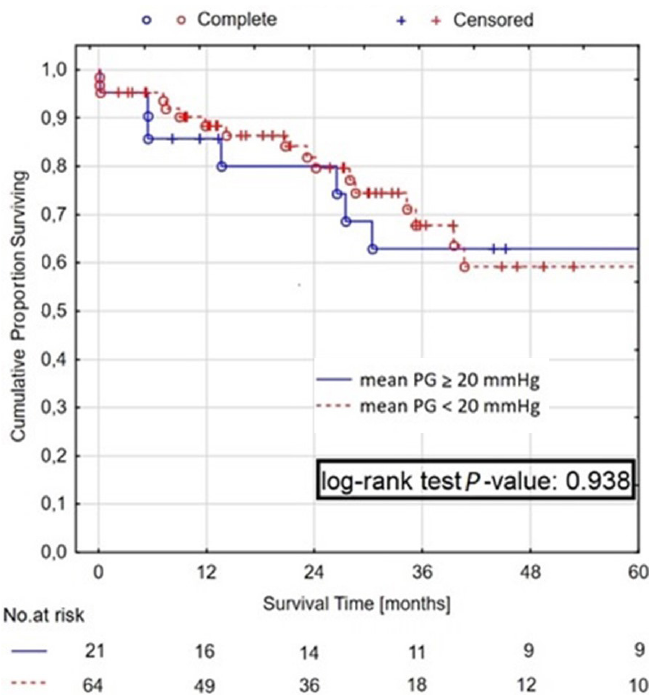
Fig. 2 - Kaplan-Meier survival curves for all-cause mortality in patient with high residual gradient (mean pressure gradient [PG] ≥ 20 mmHg) and postoperative mean transvalvular aortic gradient < 20 mmHg.